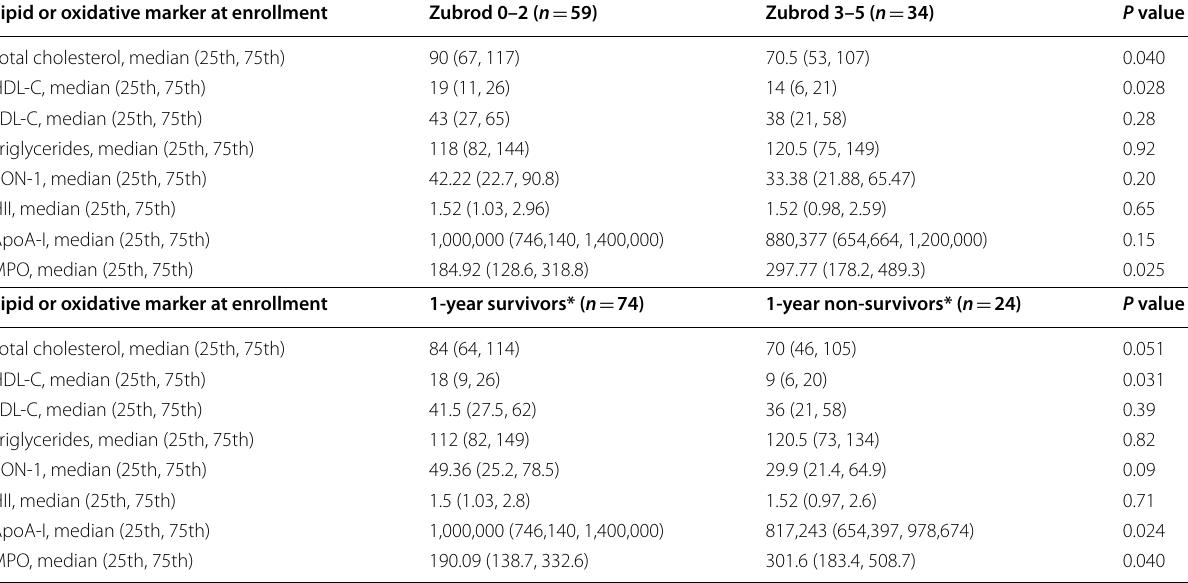
*indicate that 6 patients were lost to follow up and did not have data on 1-year